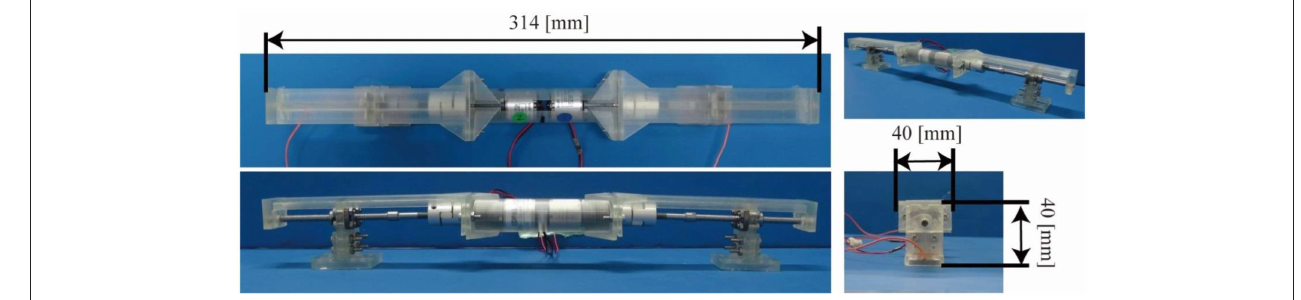
FIGURE 3 | Whole views of the inchworm search robot.